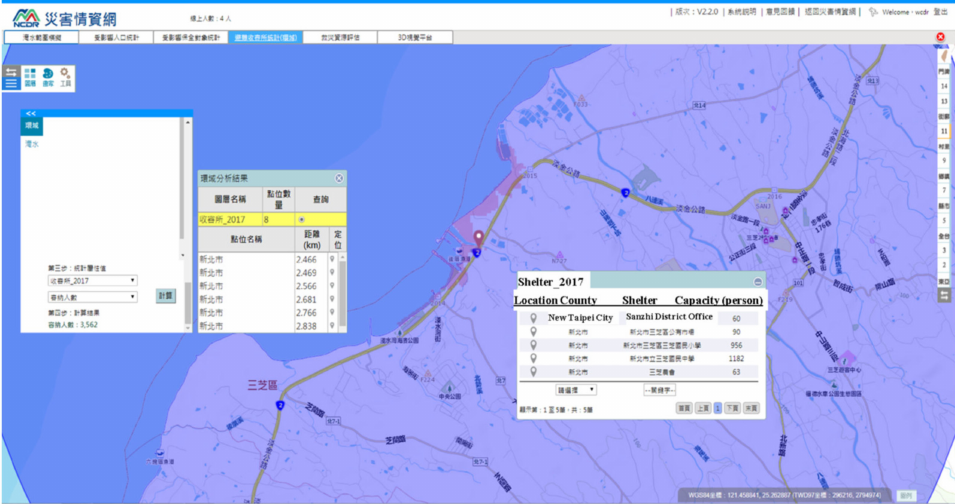
Figure 14. Buffer analysis of shelters in Sanzhi District within a 4-km buffer